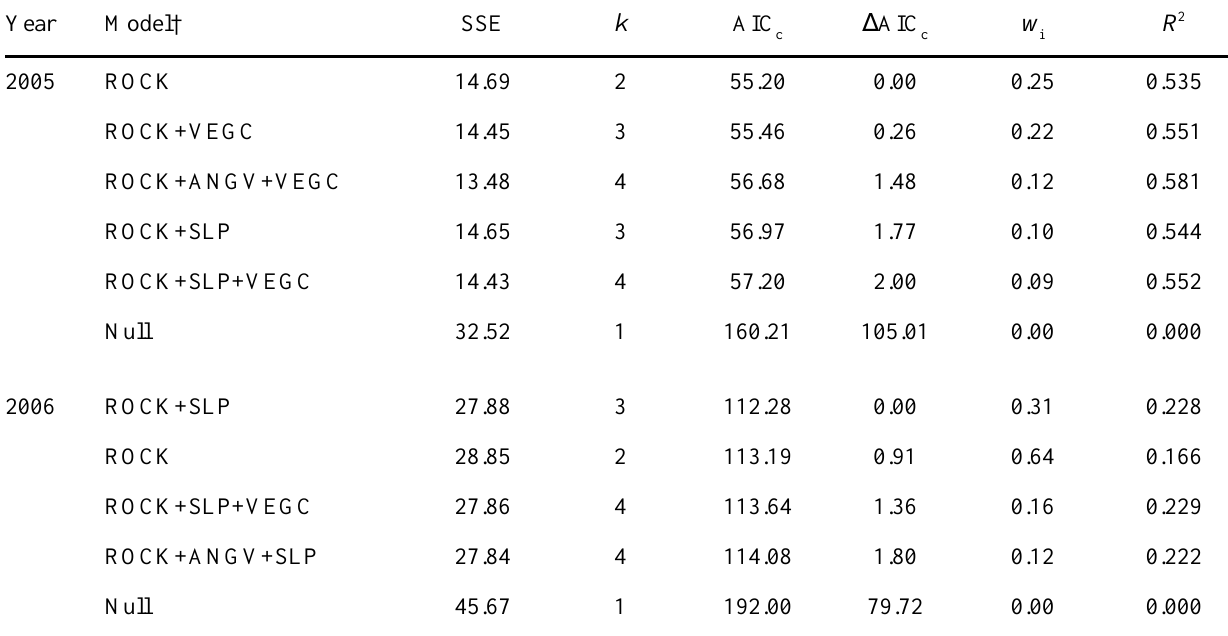
Table 3 . Summary of model selection results for models of explaining mean temperature in Fork-tailed Storm-Petrel ( Oceanodroma furcata ) nests at Kasatochi Island, Alaska. Models are listed in order of best fit in each year based on Akaike’s information criterion for small sample sizes (AIC ). Except for the null c model, only models with D AIC < 2.0 are shown. SSE is the sum of squared error, k is the number of c parameters in the model, D AIC is the difference in AIC value between each model and the top model, w c c i is the Akaike weight, and R 2 is the proportion of the total variation in success explained by the